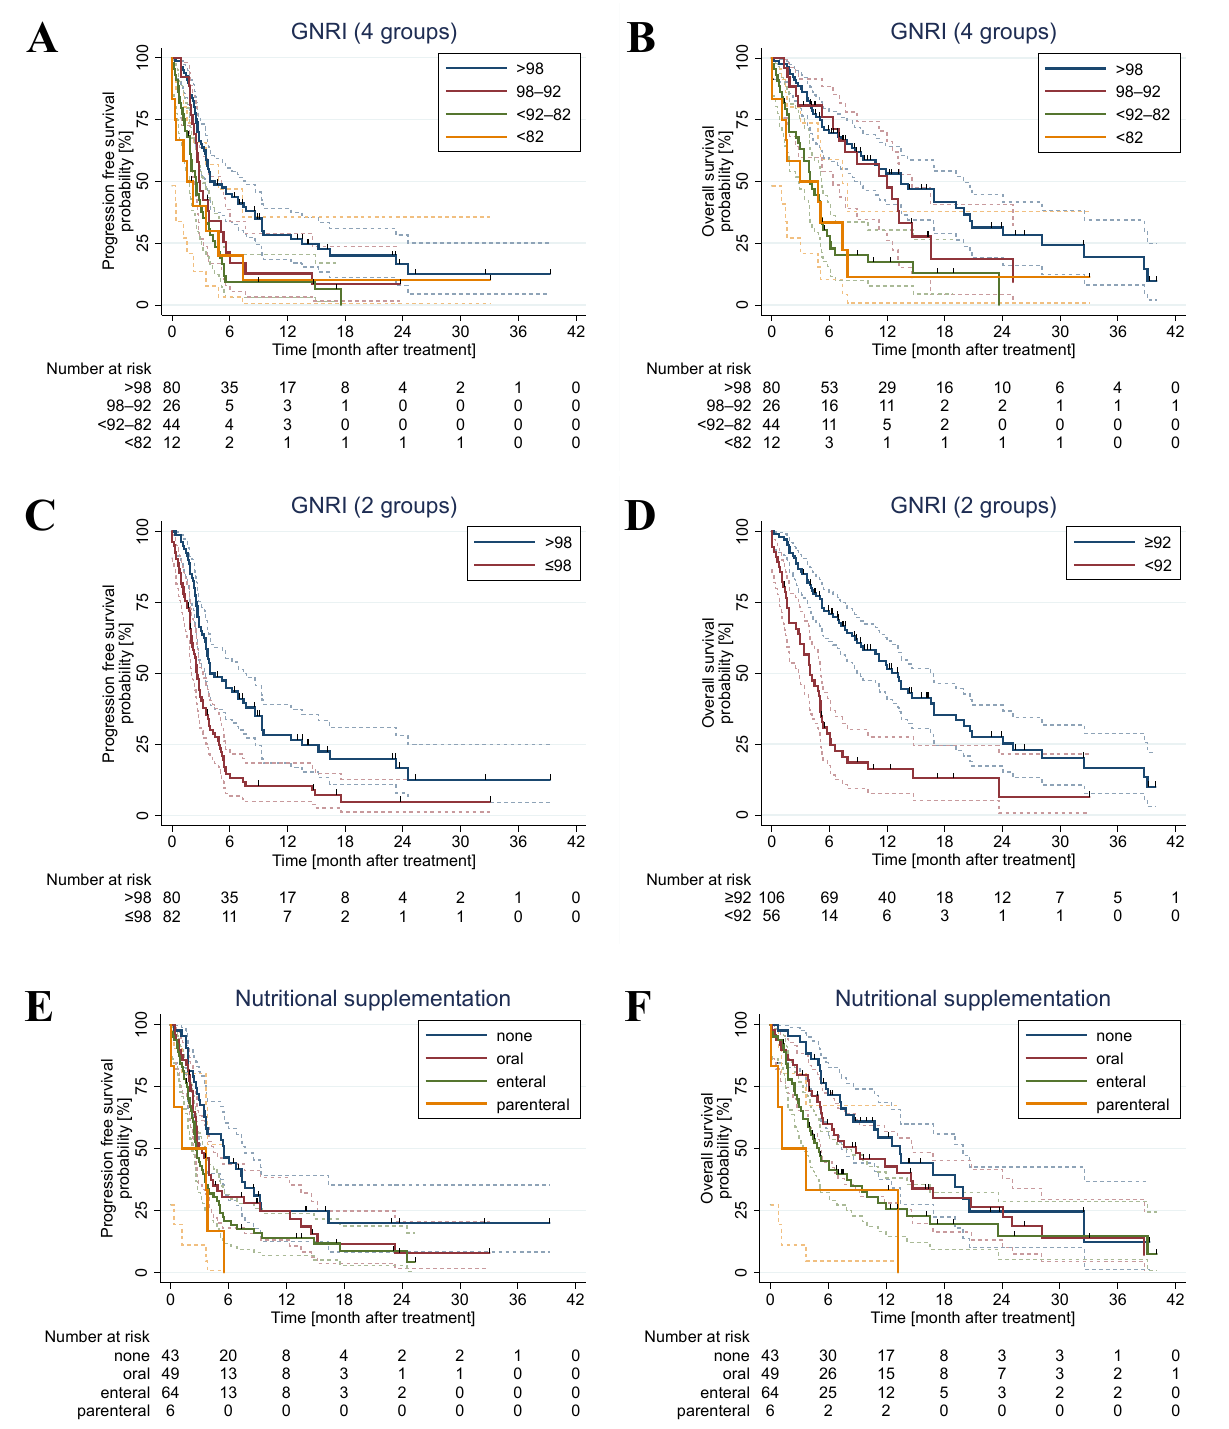
Figure 1. Survival analysis. Kaplan–Meier plots with 95% CI (dashed lines) of PFS and OS for GNRI (4 groups) ( A , B ), PFS and OS for GNRI (2 groups) cut off ( C , D ) and PFS and OS for nutritional supplementation ( E , F ). PFS, progression-free survival; OS, overall survival; GNRI, Geriatric Nutritional Risk Index.